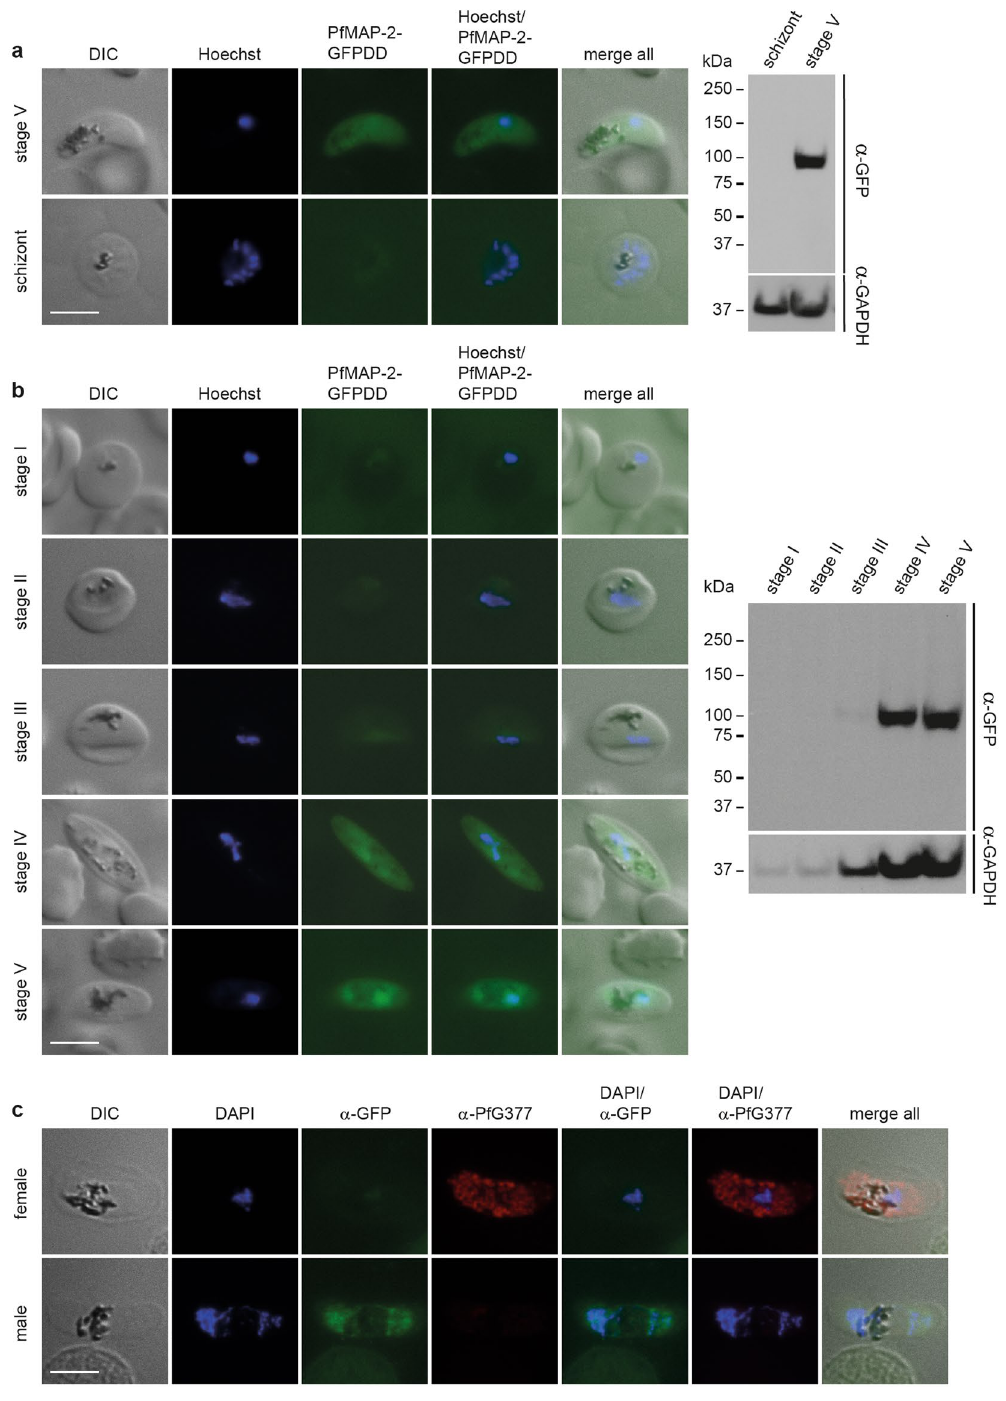
Figure 3. Expression and localisation of PfMAP-2 in NF54/MAP-2GFPDD parasites. ( a ) Expression and localisation of PfMAP-2 in late schizonts (40–48 hpi) and stage V gametocytes assessed by live cell fluorescence imaging and Western blot. Representative live cell fluorescence images are shown. Scale bar = 5 µm. For the Western blot, parasitemia/gametocytemia was determined by inspection of Giemsa-stained blood smears to ensure loading of equal parasite numbers per lane. MW PfMAP-2GFPDD = 97.9 kDa. MW PfGAPDH = 36.6 kDa (control). ( b ) Expression and localisation of PfMAP-2 in stage I to stage V gametocytes by live cell fluorescence imaging and Western blot. Representative live cell fluorescence images are shown. Scale bar = 5 µm. For the Western blot, gametocytemia was determined by inspection of Giemsa-stained blood smears to ensure loading of equal parasite numbers per lane. MW PfMAP-2GFPDD = 97.9 kDa. MW PfGAPDH = 36.6 kDa (control). ( c ) Representative images of the expression of PfMAP-2GFPDD and PfG377 in stage V male and female gametocytes assessed by IFA. Scale bar = 5 µm. See also Supplementary Fig.